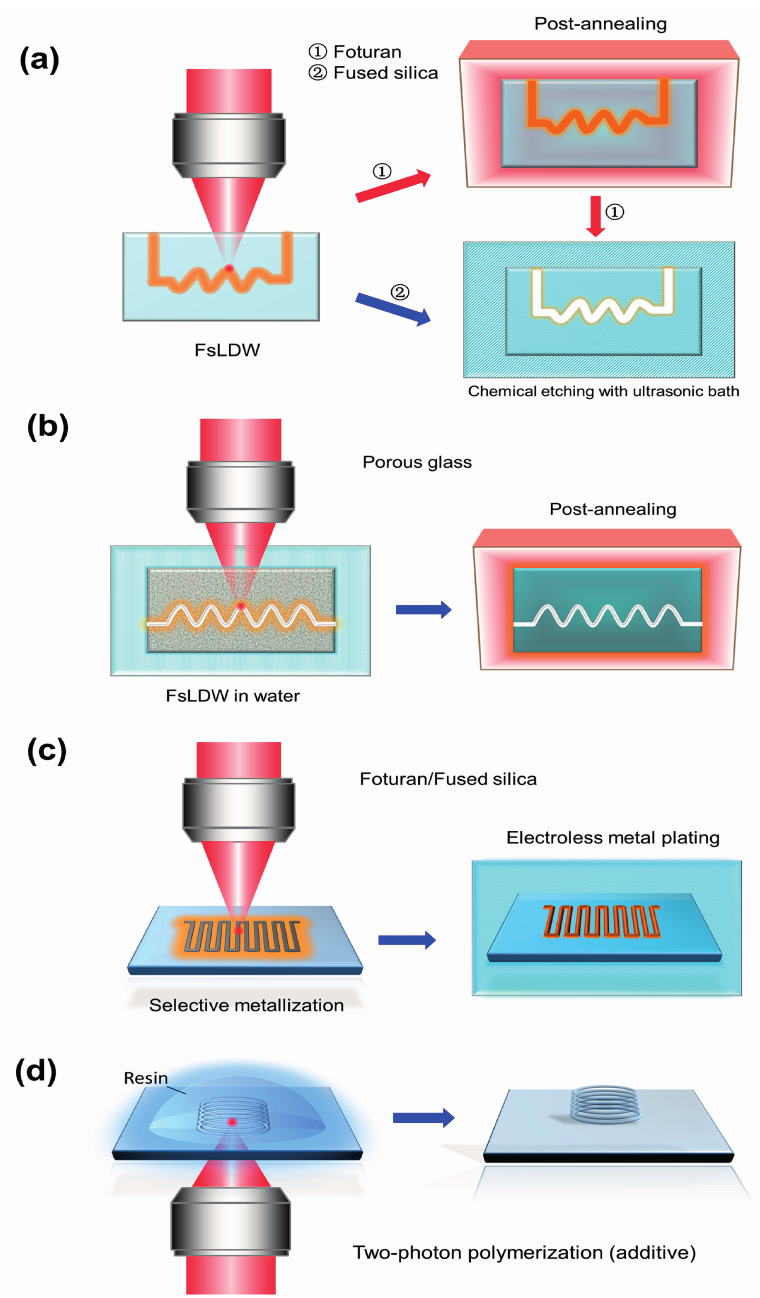
Figure 9. Schematic diagrams of fabrication procedures for ( a ) microfluidic structures in Foturan or fused silica glass; ( b ) micro- or nanofluidic structures in porous glass; ( c ) microelectronic structures on glass; and ( d ) 3D polymer micro- and nanostructures on glass substrates by two-photon polymerization